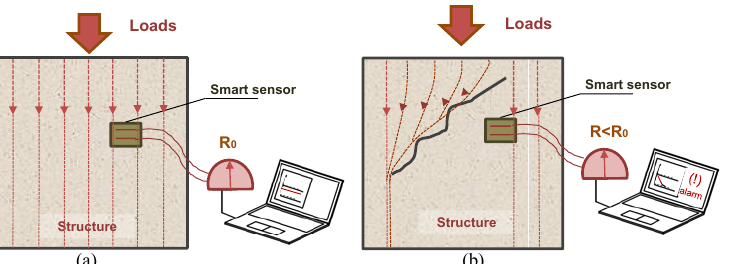
Figure 1. Sketch of the concept of a single embedded smart material sensor. ( a ) Undamaged structural element monitored with an embedded smart sensor; ( b ) behavior of the structural element and of the smart sensor after a variation in